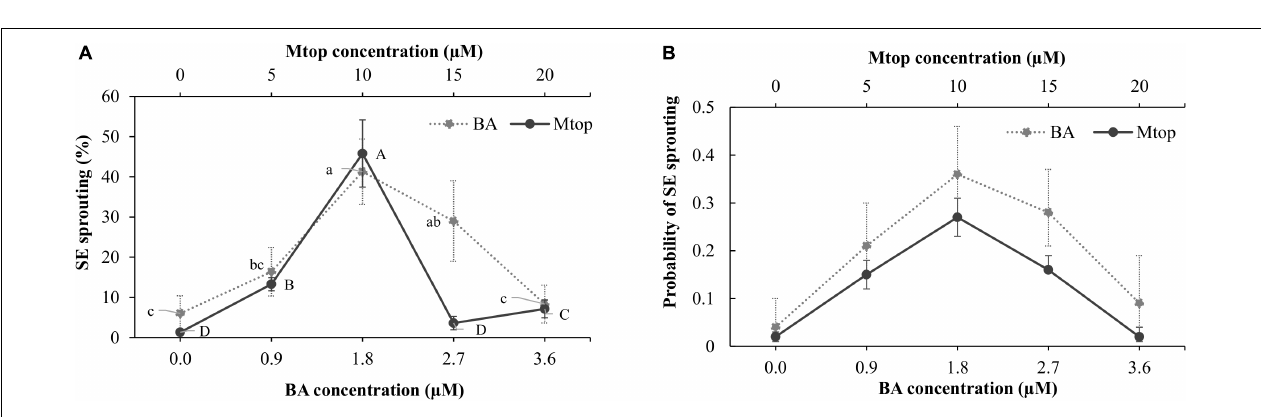
FIGURE 3 | Multiplication of hybrid papaya somatic embryos and embryogenic callus growth (A) and the proportion of globular/cotyledonary SE formed (B) in liquid and semi-solid culture systems after a 2-month culture period. Statistical differences between treatments are shown as letters ( p < 0.05). SE, Somatic embryos.